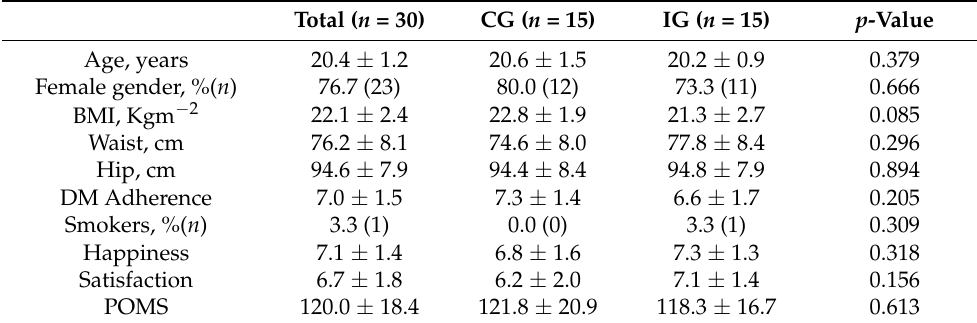
BMI, body mass index; DM adherence, adherence to the Mediterranean diet; CG, control group; IG, interven- tion